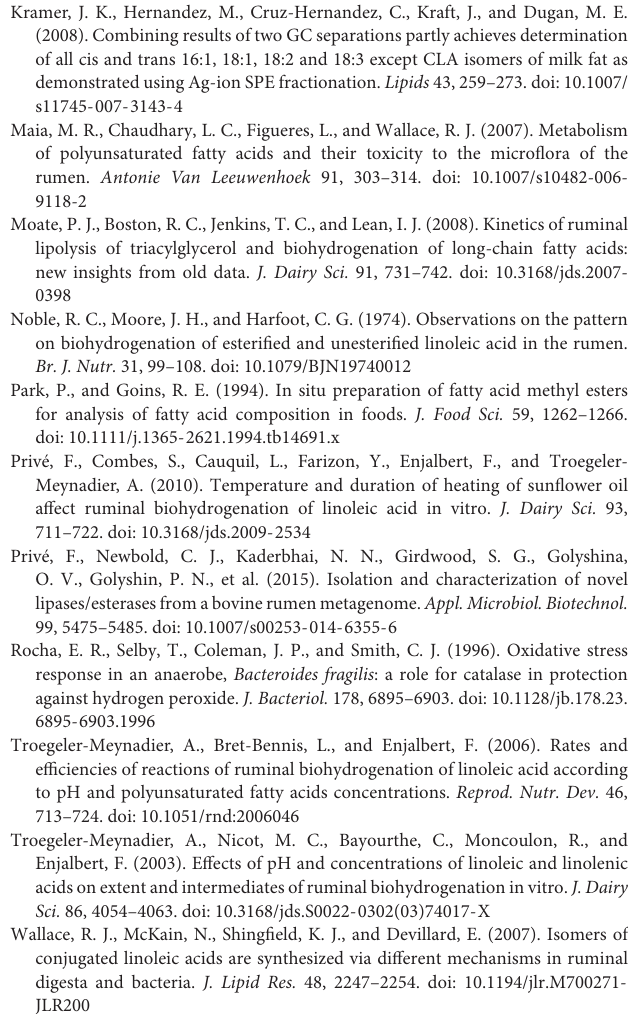
TABLE S1 | Amount (mg) of intermediates of C18:2n-6 biohydrogenation according to incubation duration (Experiment 1.1). TABLE S2 | Amount (mg) of intermediates of C18:3n-3 biohydrogenation according to incubation duration (Experiment